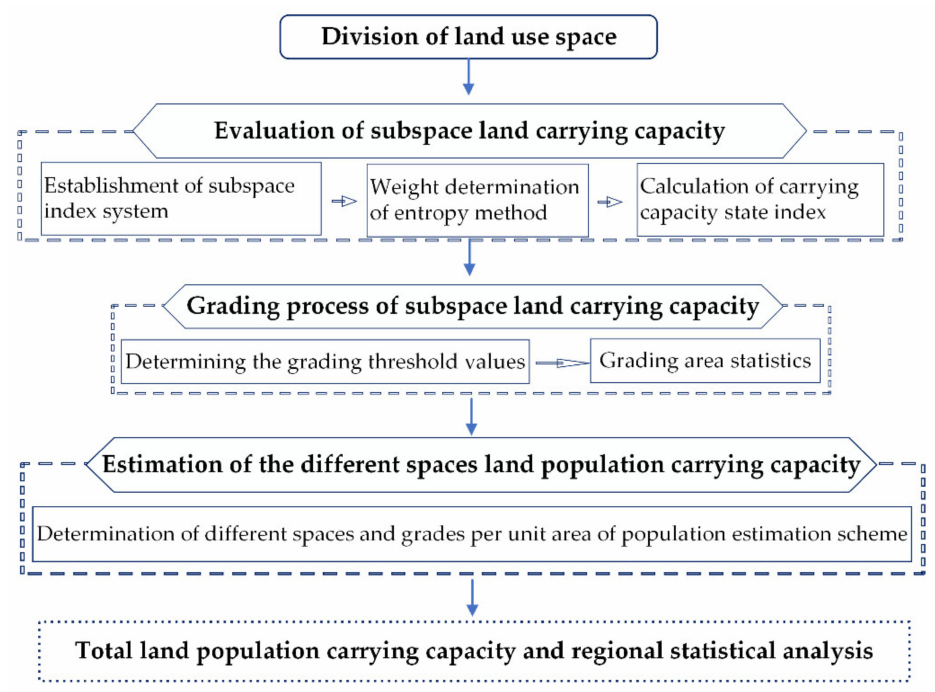
Figure 2. Estimation process of land population carrying capacity based on